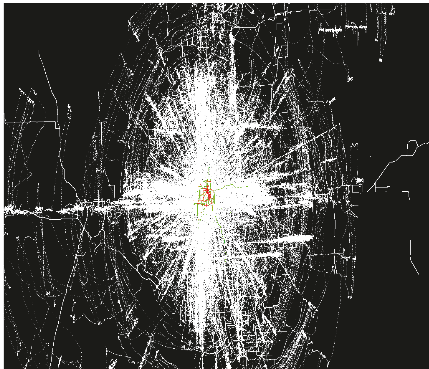
Figure 3: Visualization of traffic density of vehicles with devices for data